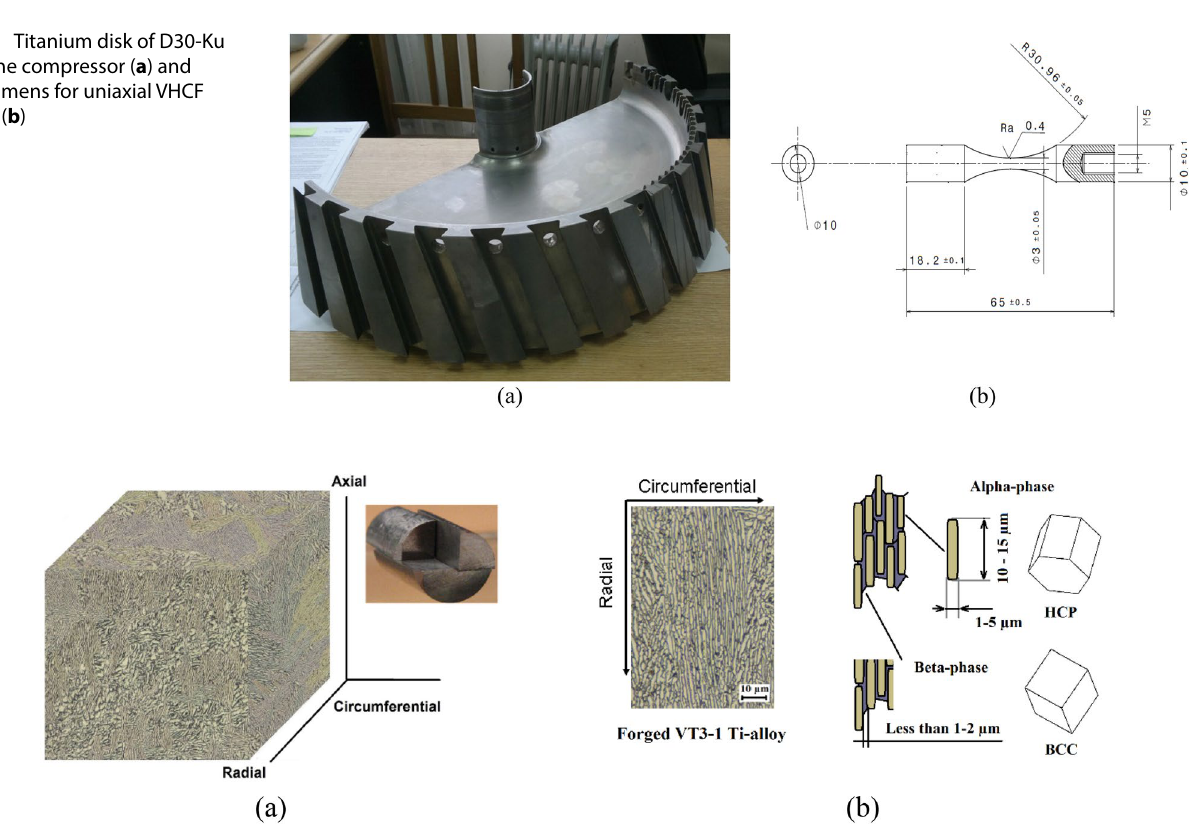
Fig. 4 Microstructure of titanium alloy VT3-1 in three mutually perpendicular planes ( a ) and schematic representation of microstructural elements ( b